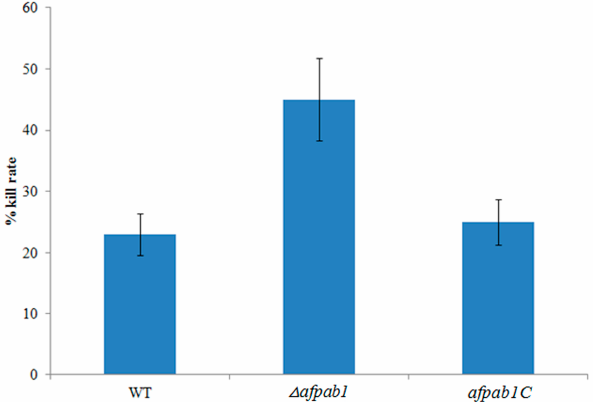
Figure 10. Percentage of killing by macrophage cells of conidia obtained from WT, Δ afpab1 , and afpab1C . The killing rate for each strain was determined from three independent experiments. Data were shown as the mean ± SD, p < 0.05.